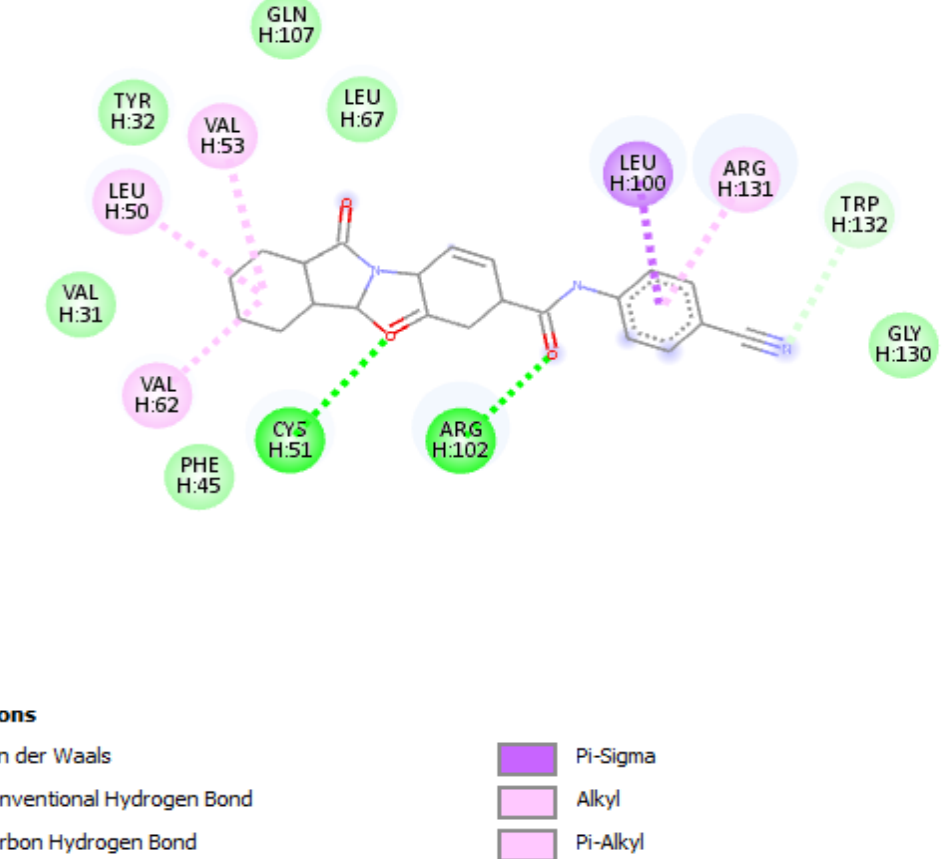
Figure 4. Positioning and interactions of the molecule F3374-0275 inside the active site of receptor HPV16E6 (PDB ID 4xr8).